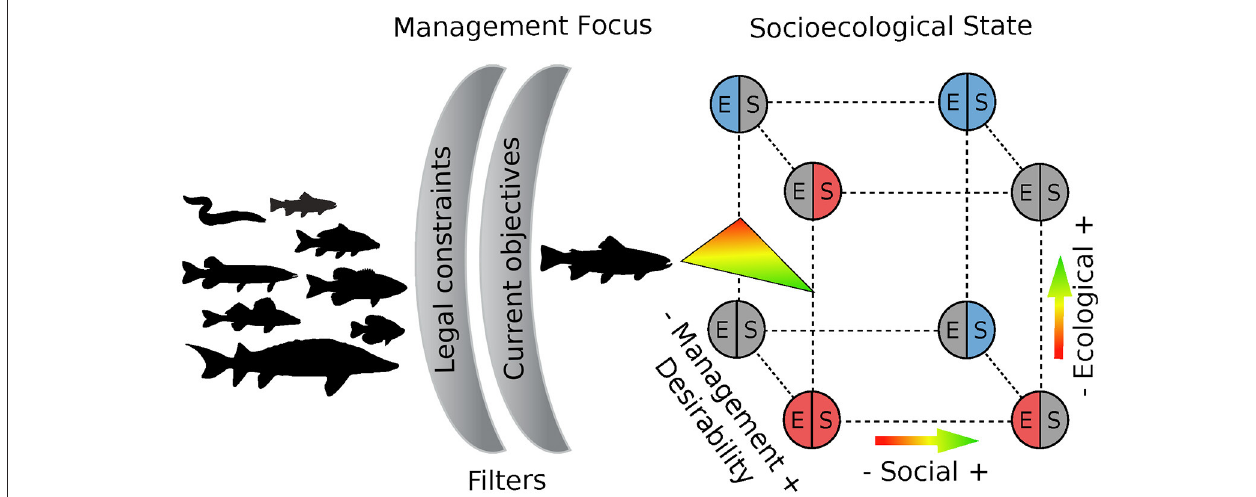
FIGURE 1 | Evaluating management resilience with respect to a focal species. Management resilience is evaluated with trout as the focal species filtered through legal constraint and current management objectives that help to determine the relevance of the species to management. The desirability of the species will fall along a spectrum (– to + ) and can then be evaluated with respect to the spectrum of social (S) and ecological (E) forces (– to + ). At the extremes, the nodes indicate the management action required to enhance resilience, with gray indicating no action, blue indicating management actions aimed at reducing the forcing component, and red indicating management actions aimed at enhancing the forcing component.